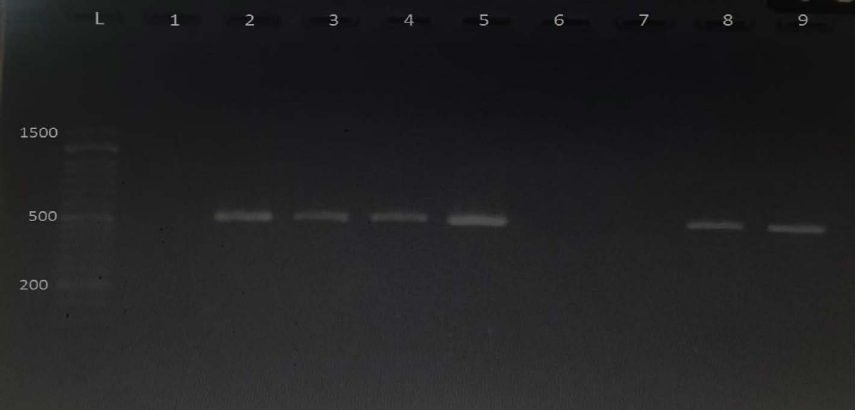
Fig. 5. Gel electrophoresis of PCR products of cnfA gene visualized under U. V light after mixed with ethidium bromide. L: 1500 bp DNA marker; lane 2-5,8,9 positive for cnfA gene and lane 1, 6,7 negative result. The product size is 498